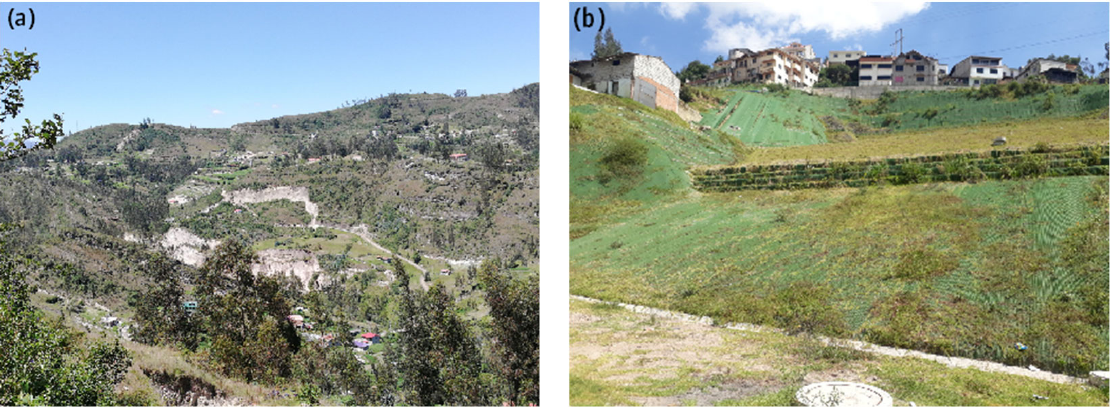
Figure 3. Photographs of some rotational landslides located in the study area: ( a ) south and ( b ) north (near to urban zone).